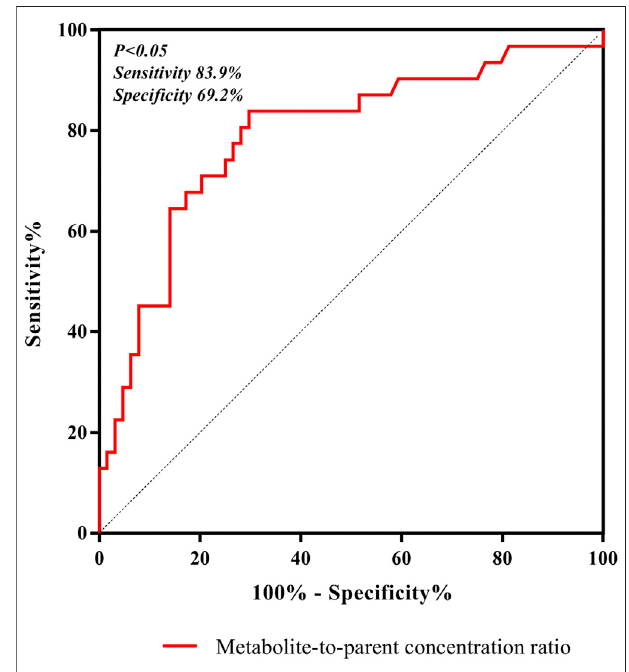
FIGURE 5 | ROC curve of metabolite-to-parent concentration ratios for linezolid-associated myelosuppression, and showed that the ratio higher than 1.31 was identi fi ed as a risk